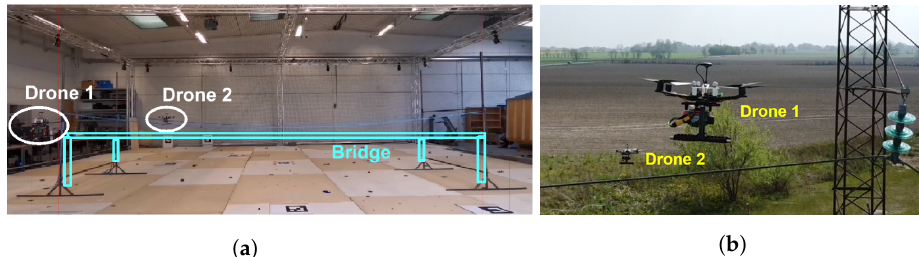
Figure 14. Formation flying with two drones in autonomous swarm operation. ( a ) indoor test in drone laboratory; ( b ) outdoor test near powerline